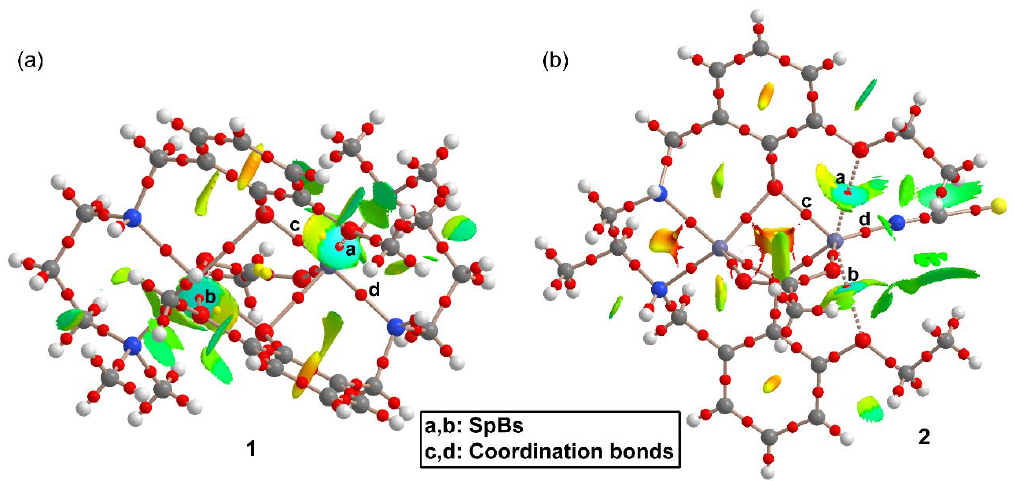
Figure 5. Quantum theory of atoms in molecules (QTAIM) and noncovalent interaction (NCI) method analyses combined in the same representation for compounds 1 ( a ) and 2 ( b ). Noncovalent bond paths are represented as dashed lines. Table 2. Electron charge density ( ρ ), its Laplacian ( ∇ 2 ρ ), kinetic (V), Lagrangian (G) and total (H) energy densities at the bond critical points (CPs) labelled in Figure 5 for compounds 1 and 2 in a.u.